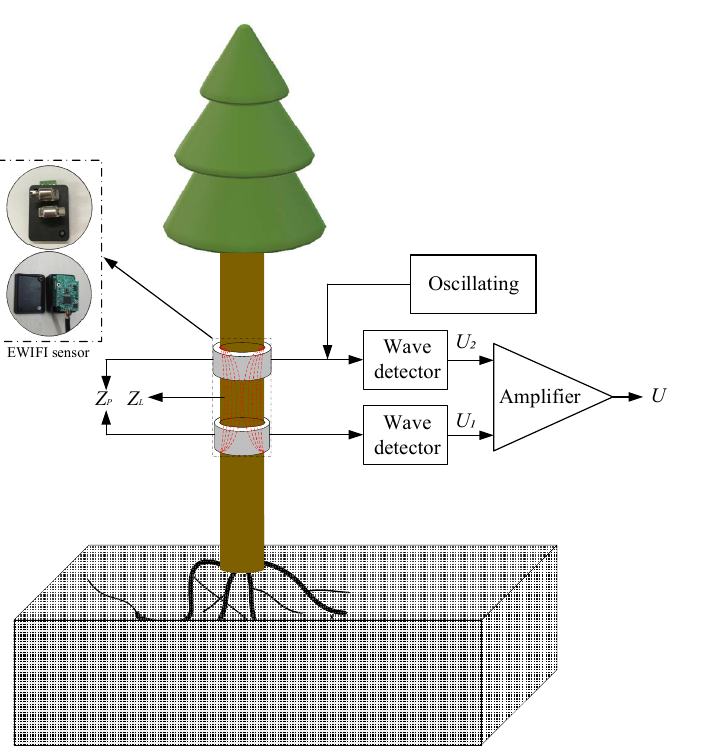
Figure 1. Schematic diagram of the electromagnetic wave inner fringing impedance (EWIFI) sensor. Sensor output voltage ( U ), output voltage at both ends of transmission line ( U 1 and U 2 ), transmission line and probe impedance ( Z P ), plant impedance at the probe ( Z L